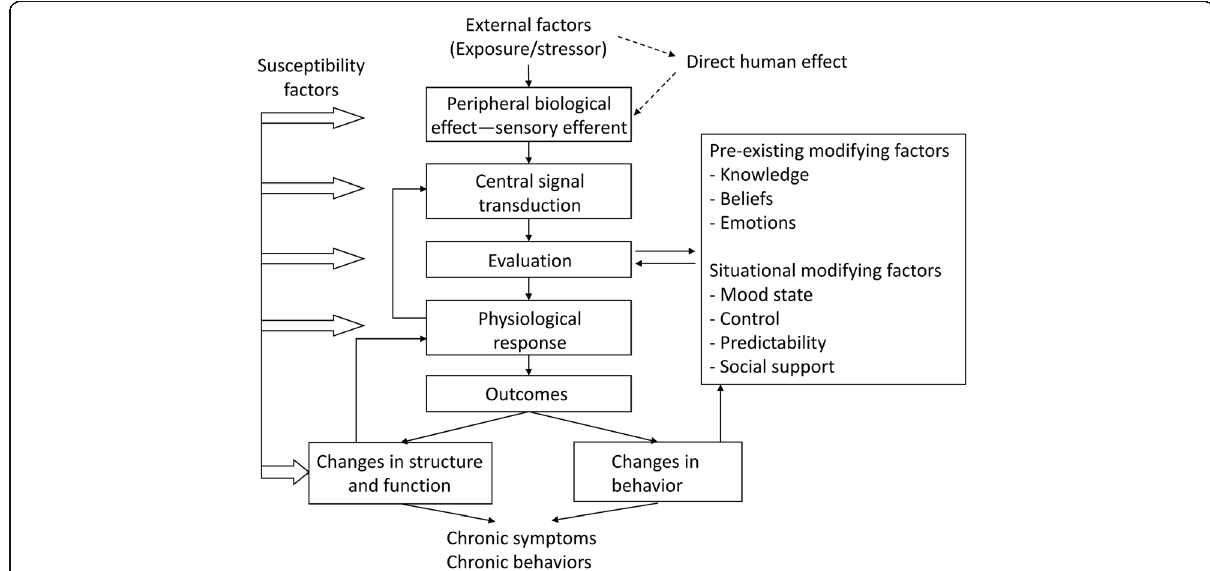
Fig. 1 Mechanistic model of the interrelationships among external factors, susceptibility factors, and symptoms (reproduced from Kipen and Fiedler [63] published in Environmental Health Perspectives with permission from the